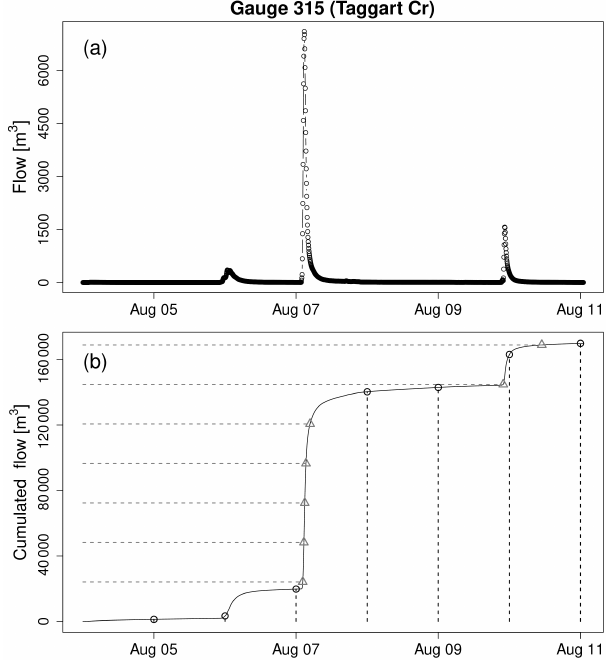
Figure 3. Illustration of inter-amount data sampling for cumulative flow over a period of 7 days, for Taggart Creek. (a) Flow data series at original 15min observational resolution; (b) cumulative graph for flows and IATs at the same mean sampling resolution, illustrating how adaptive sampling based on IATs differs from classical fixed- time